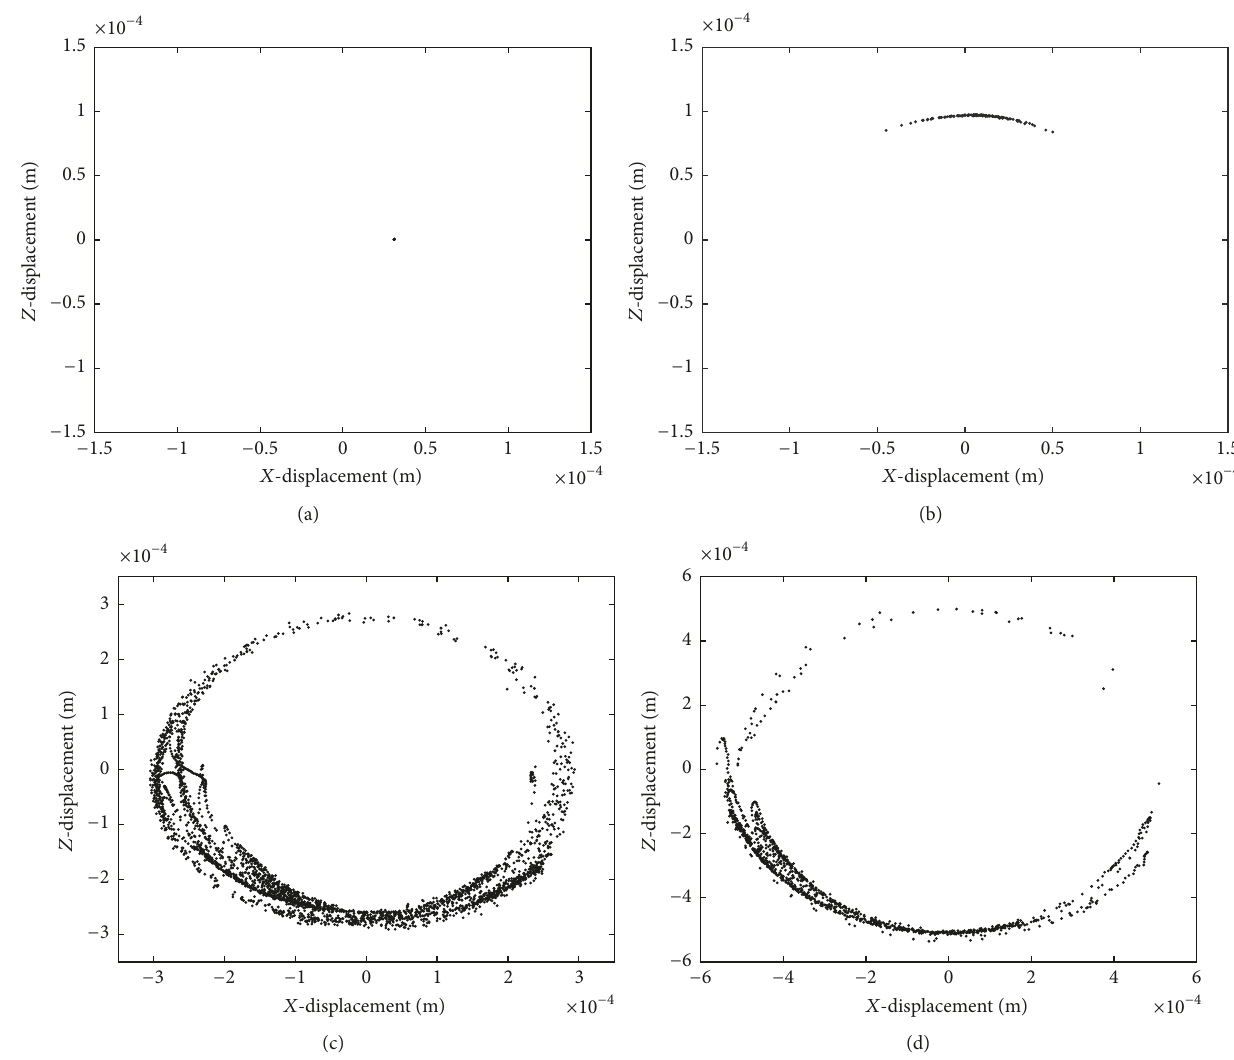
Figure 18: Poincare maps of different clearances: (a) 𝑐 = 0.01 mm; (b) 𝑐 = 0.1 mm; (c) 𝑐 = 0.25 mm; (d) 𝑐 = 0.5